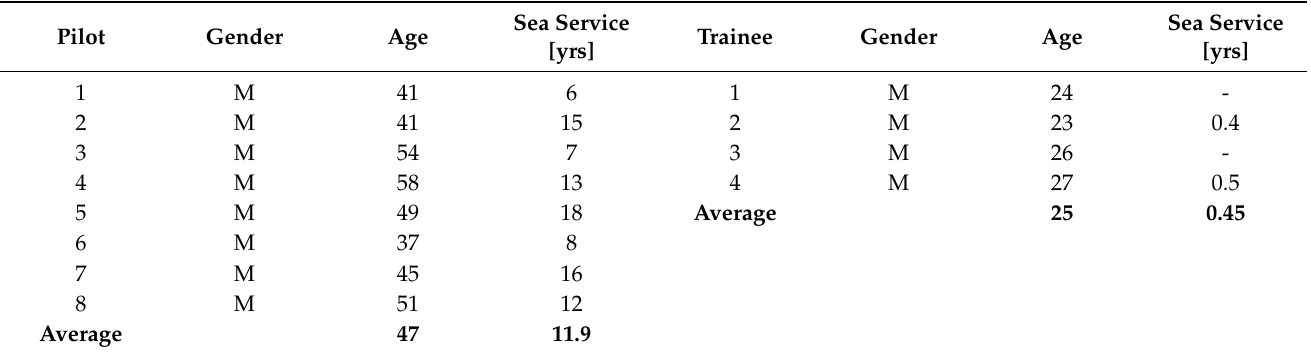
Table 1. The participants’ detailed data: the experienced group’s average age is 47 years (SD = 6.8) with 11.9 years of sea service (SD = 4.1); the trainees’ average age is 25 years (SD = 1.6) and without significant length of sea